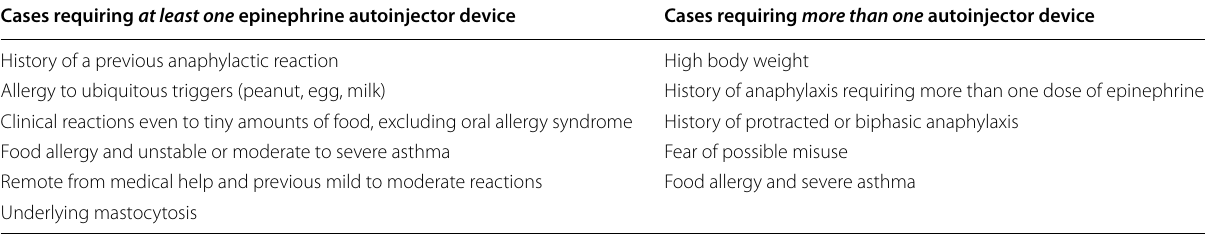
Table 4 Indications for prescription of epinephrine auto-injectors Cases requiring at least one epinephrine autoinjector